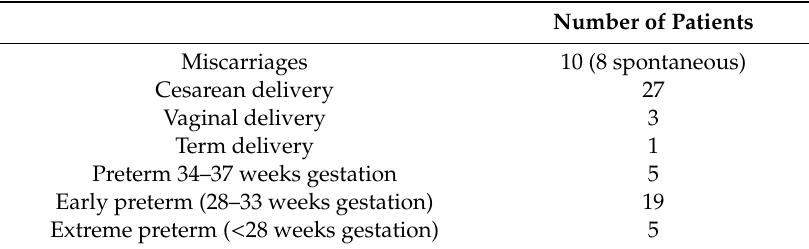
Table 3. Maternal–fetal